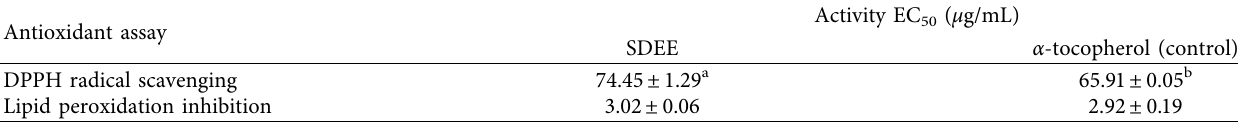
Table 2: Antioxidant activities of the saponifed diethyl ether extract pili pulp oil.